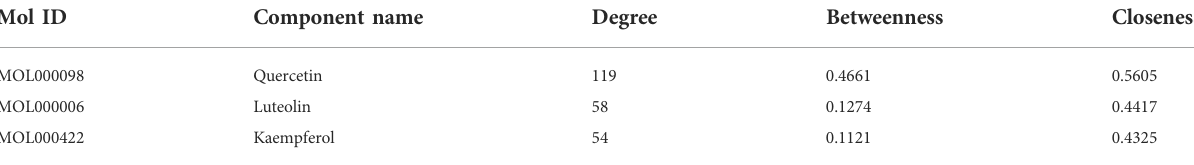
TABLE 4 The node characteristic parameters of main active ingredients in the compound-target. Mol ID